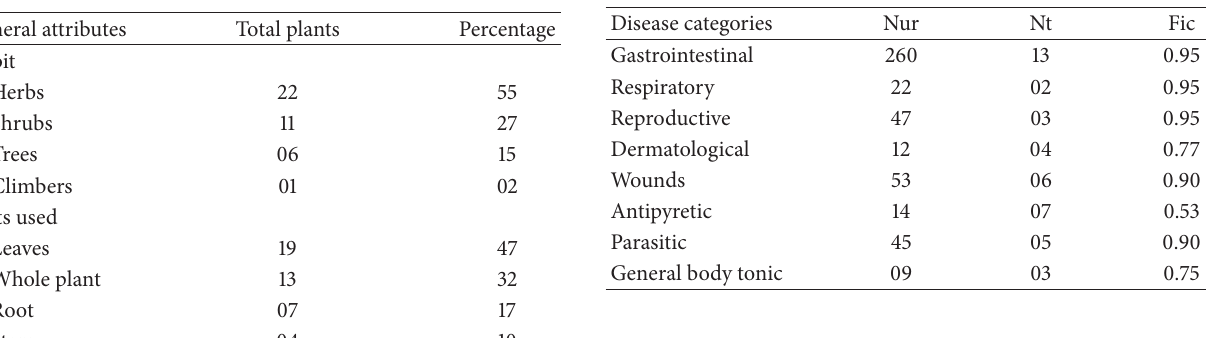
Table 2: Habit and parts used of ethnoveterinary plants. Table 3: Informant consensus